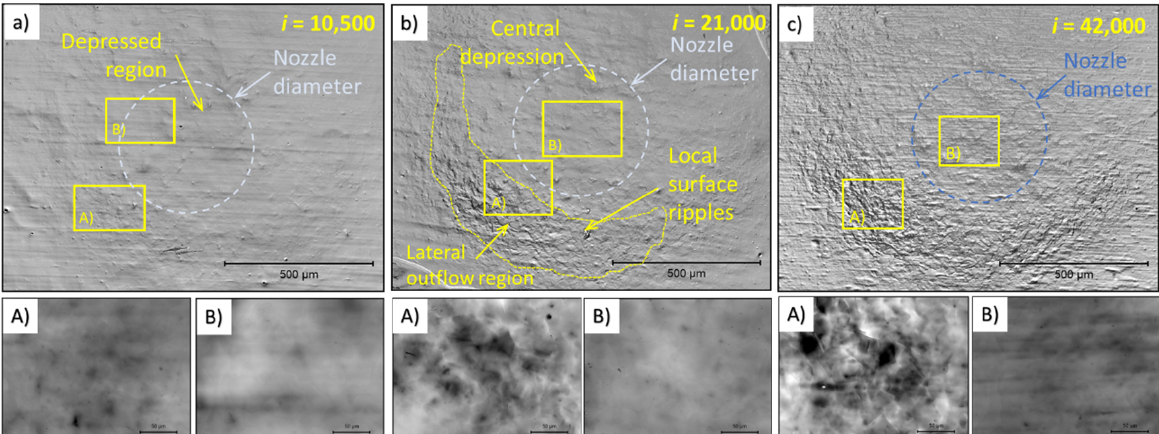
Figure 5. Results of confocal microscopy showing the evolution of erosion damage to the polished surface of AISI 316L stainless steel with increasing cumulative impingement numbers ( a ) is 10,500 impingements, ( b ) is 21,000 impingements and ( c ) is 42,impingements. The impingements are from a stationary source using an ultrasonic pulsating water jet with an impact velocity of 150 m/s and water cluster diameter d of 0.4 mm, indicated by the dashed line.